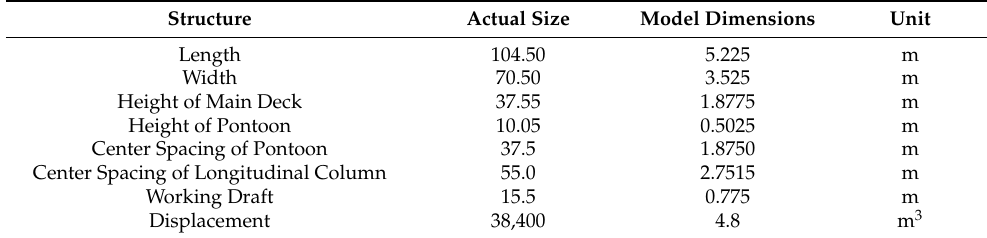
Table 5. Main dimensions of the